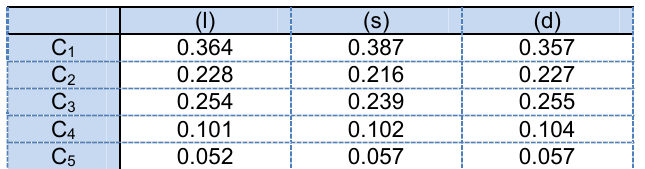
Table 6 – Fuzzy weight coefficients of the evaluation criteria Таблица 6 – Нечеткие весовые коэффициенты критериев оценки